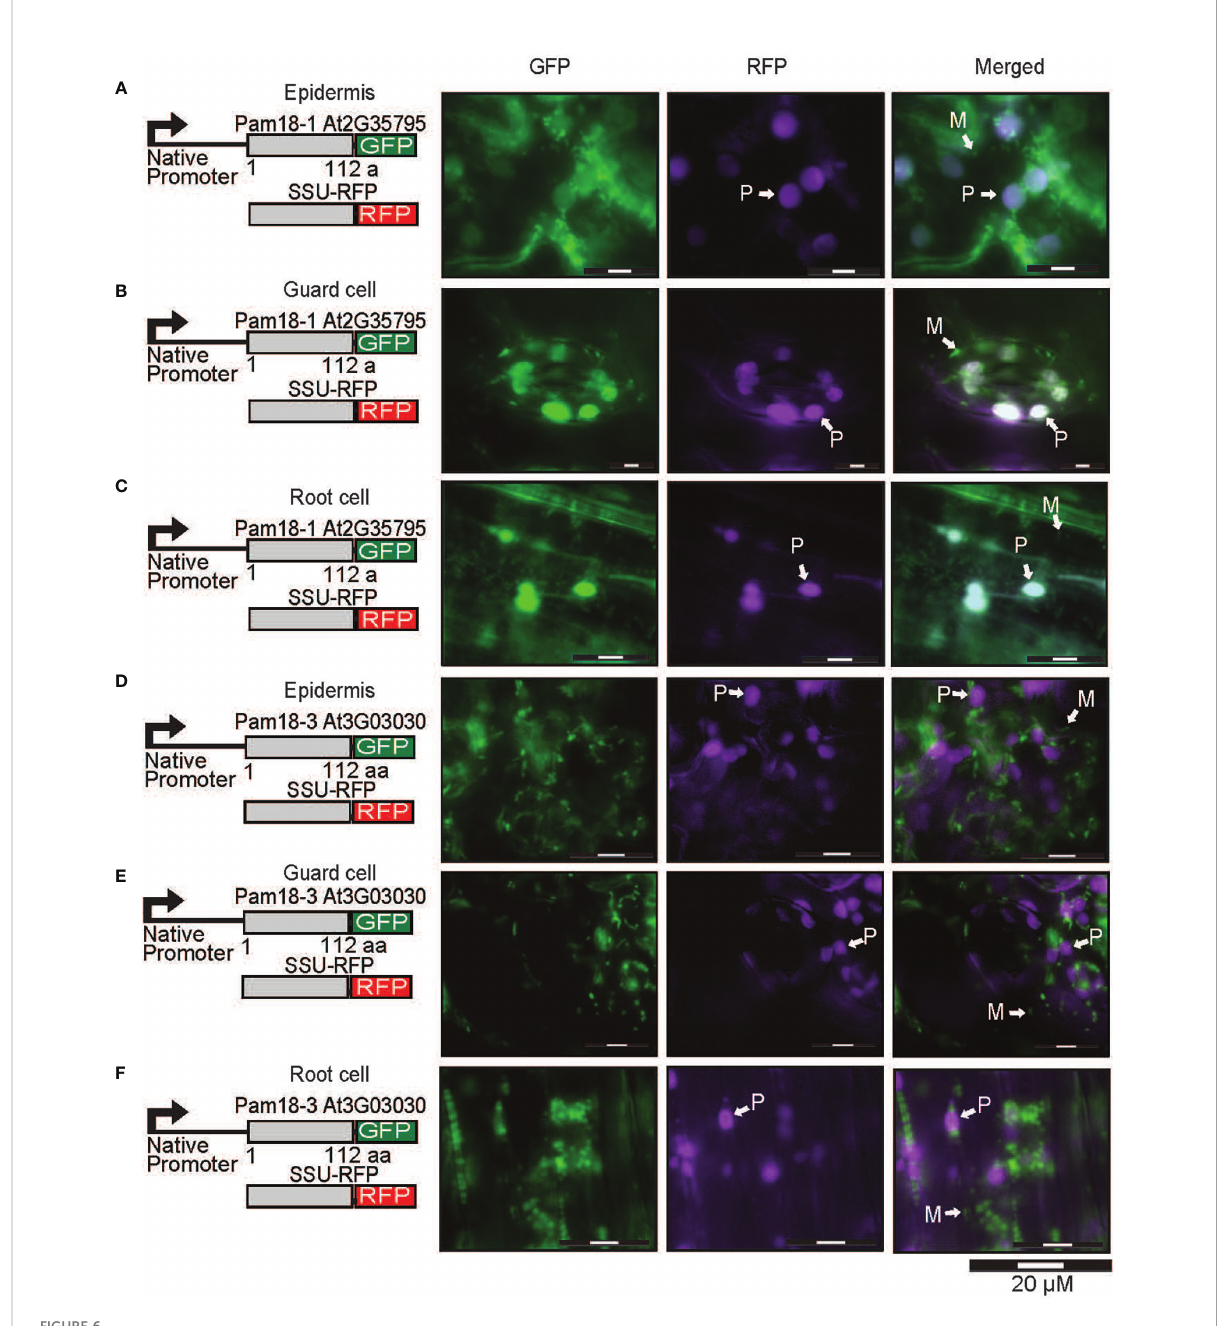
FIGURE 6 Pam18-1 and Pam18-3 GFP under endogenous promoters and plastid targeted-RFP (SSU-RFP) in stable transgenic Arabidopsis seedlings. Images taken from 3 weeks old Arabidopsis T2 transformants of root, epidermal, and guard cells Pam18-1 (A – C) . Pam18-3 (D – F) . Scale bar indicates 20 m M. M, mitochondria, P,